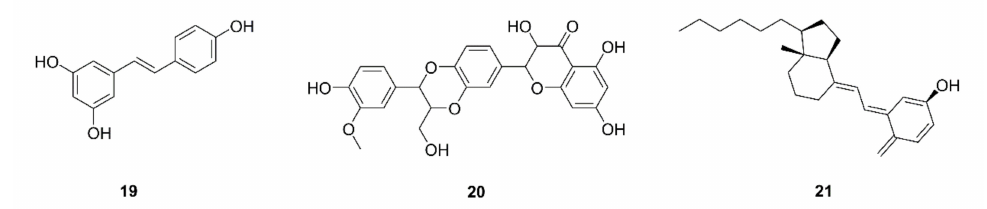
Figure 4. Chemical structures of natural compounds targeting MDSCs ( 19 – 21